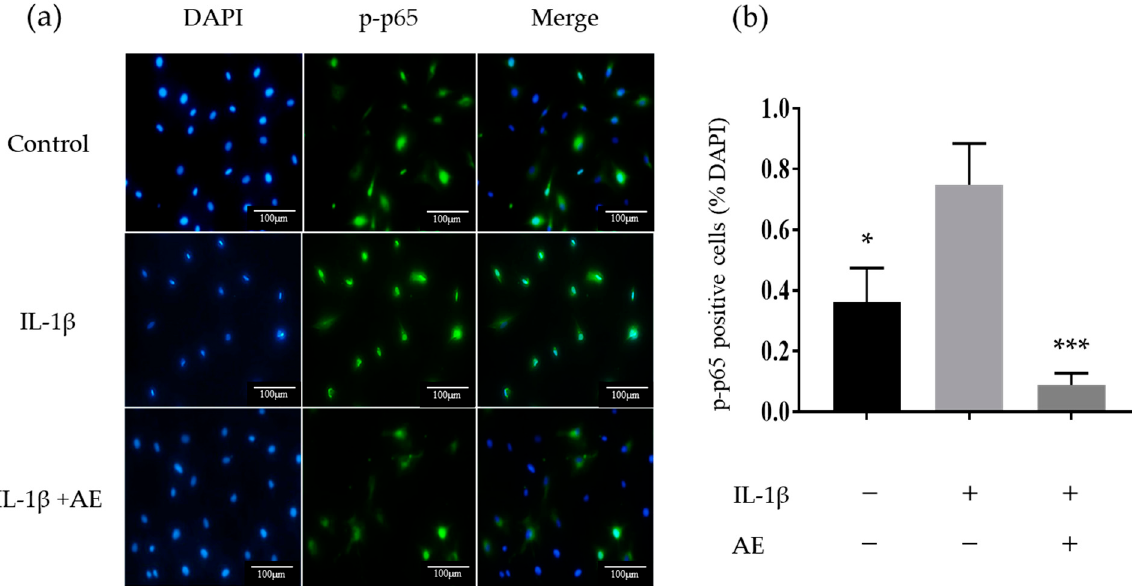
Figure 3. Immunocytochemistry of p-p65 expression. ( a ) Representative image showing the localization of p-p65 in chondrocytes. Original magnification ×200. ( b ) Percentages of p-p65 positive cells relative to total cell numbers. Data are shown as the mean ± SD of five fields. Statistical significance: Tukey’s multiple comparisons test * p < 0.05, *** p < 0.001 relative to the result of IL-1 β stimulation without AE.